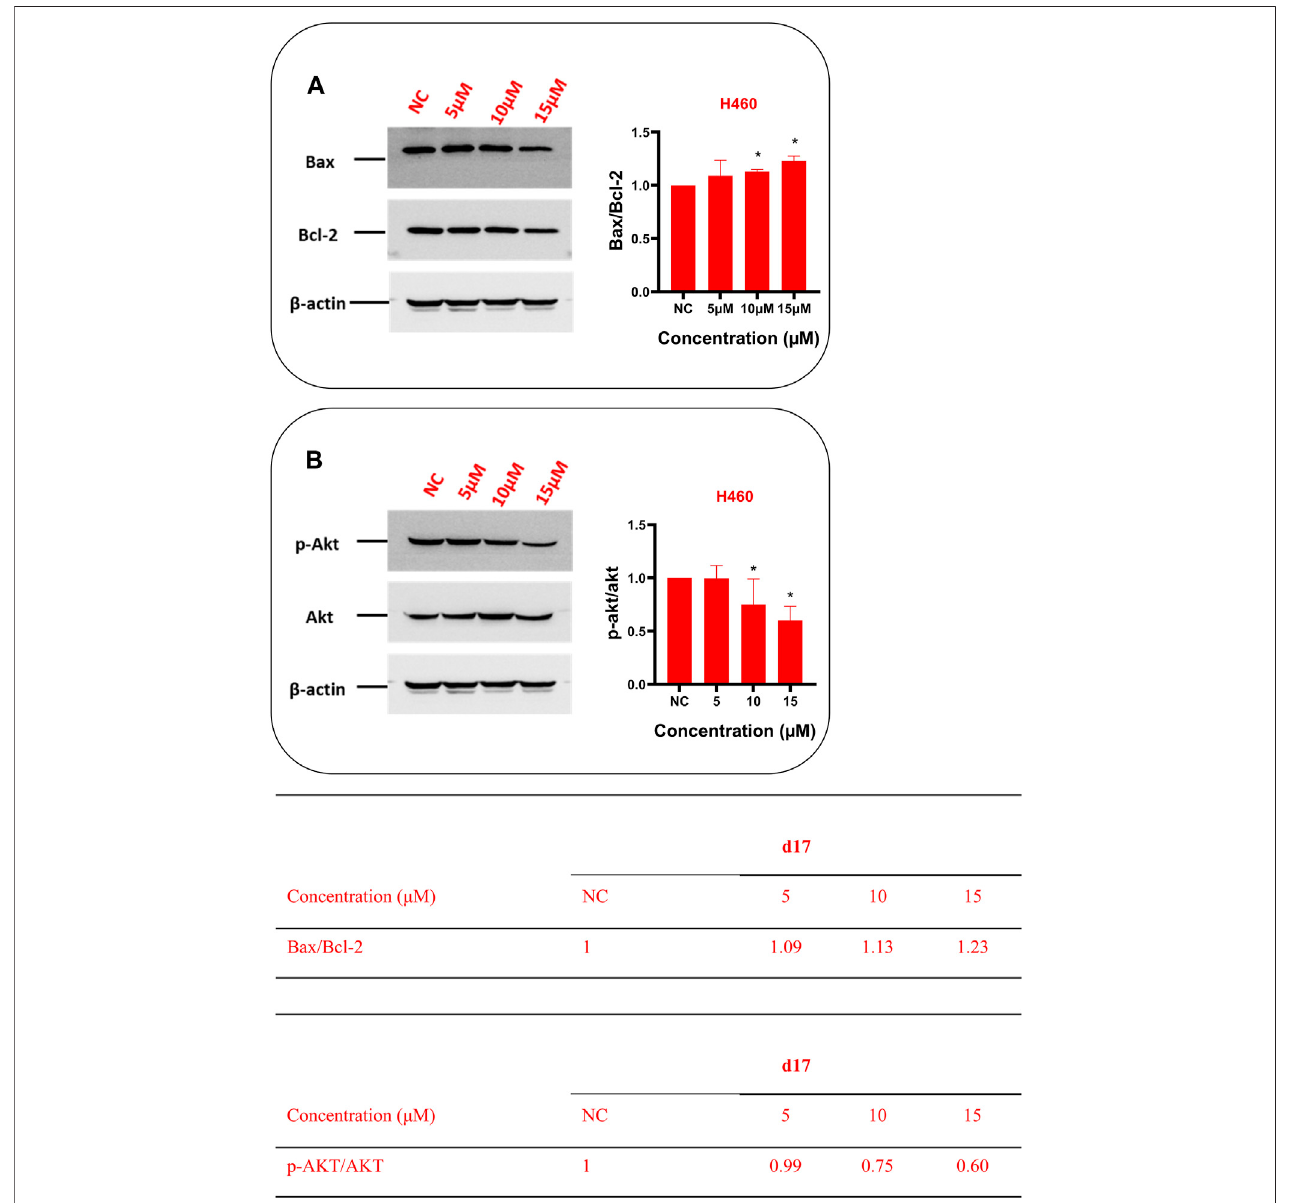
FIGURE5| Compound d17 suppressed Aktphosphorylation and its transduction ofdownstream signaling Bax and Bcl-2 inNSCLCcells. Western blot wasused to detect apoptosis-related markers Bax, Bcl-2 (A) , and Akt (B) . Protein bands (left images) and quanti fi cation (right images and tables below) are presented. NC, negative control. * p -value < 0.05, ** p -value < 0.01, and *** p -value < 0.001 (one-way ANOVA, followed by Tukey ’ s post-test).